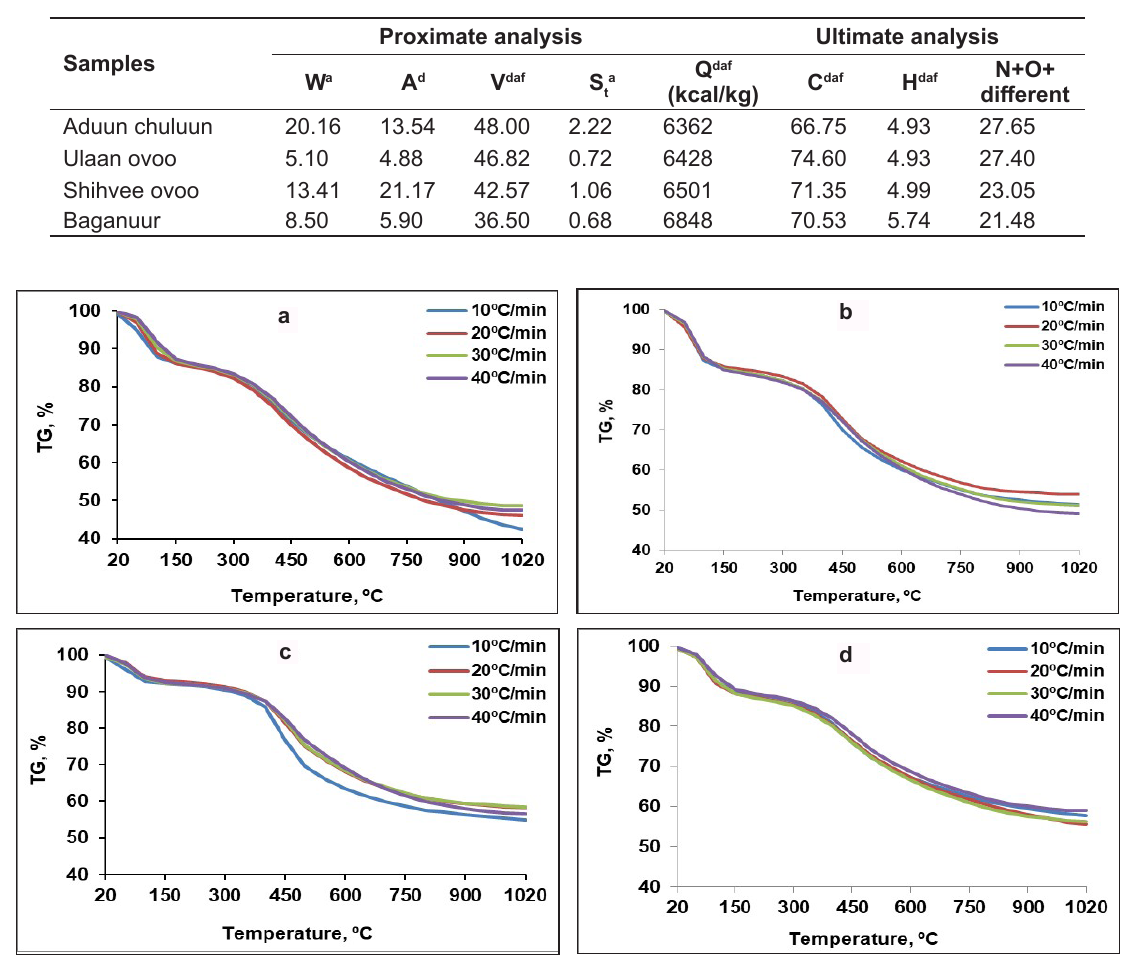
Fig. 1. Weight loss of coals a-Aduun chuluun, b-Baganuur, c-Ulaan ovoo, d-Shivee